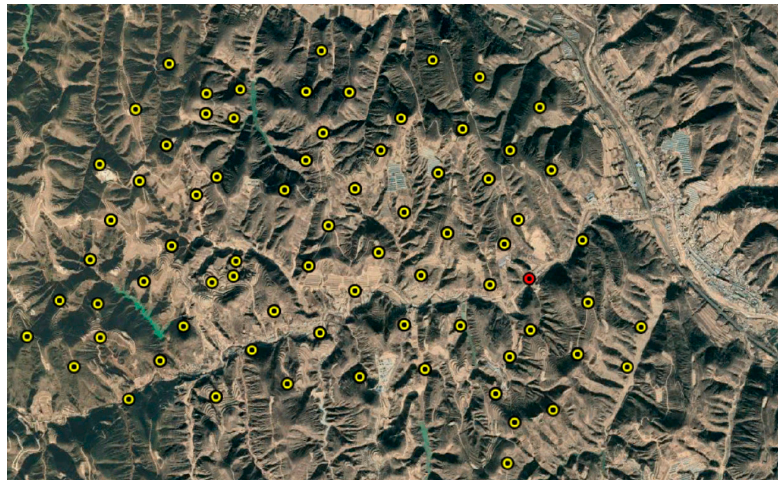
Figure 11. Combined well and ground observation system (red dot in the figure is the position of instruments in the well, and yellow dots are the positions of instruments on the ground).